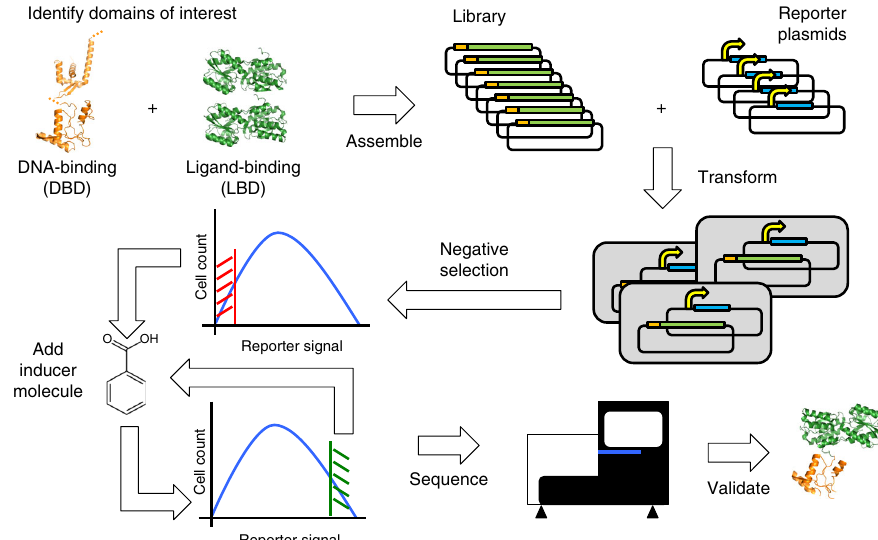
Fig. 1 Pipeline for the generation of novel TFs through gene fusion. Starting top-left, the process starts with the selection of the DNA-binding domains (DBDs), regions from preexisting TFs that interact with DNA on speci fi c operator sequences, and the ligand-binding domains (LBDs) that provide the chimera with inducer speci fi city. Libraries of TFs are assembled combining DBDs and LBDs. In parallel, a set of reporter plasmids was developed. Each reporter plasmid contained a modi fi ed Ptac promoter in which LacI operator boxes had been replaced by operator sequences for one of the DBD included in the collection of chimeras. Both the library of chimeras and the library of reporter plasmids were transformed into E. coli host cells. A fi rst negative selection is performed using FACS to enrich the libraries in properly paired DBD/reporter plasmids: bacteria containing chimeras whose DBD were unable to recognize the operator boxes included in the reporter plasmid could not repress the transcription of a reporter gene encoding GFP. Non-GFP- fl uorescent bacteria were recovered and subsequently exposed to the inducer molecule (benzoate). In this case the chimeras that were able to derepress the reporter promoter allowed the transcription of GFP, facilitating the positive discrimination of inducible chimeras. This positive selection was iterated and the relative abundance of every chimera compared before and after the selection. Both the starting and fi nal libraries were sequenced, assessing the relative abundance of every chimera. Candidate TFs enriched in the fi nal library were individually assayed in vivo. Protein structures in orange and green: PDB 1MJL, 3F8C, and